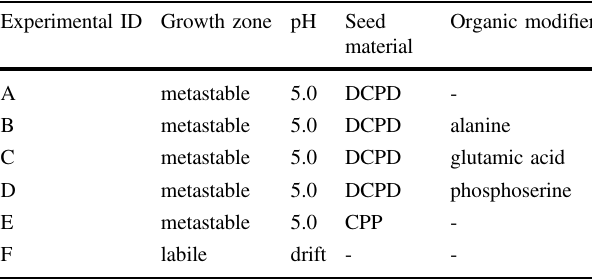
Table 1 Summary of experiments carried out in DCPD metastable and labile zones Experimental ID Growth zone pH